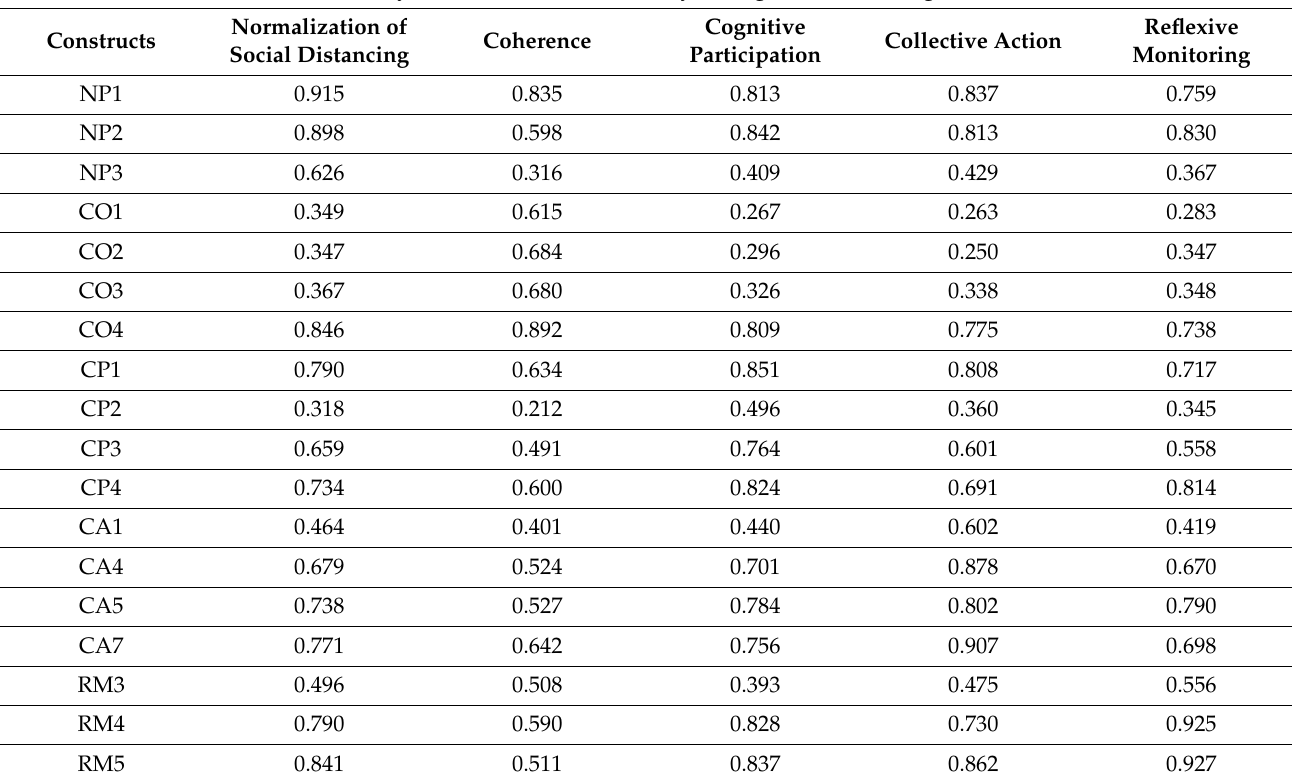
Table 2. Analysis of discriminant validity.